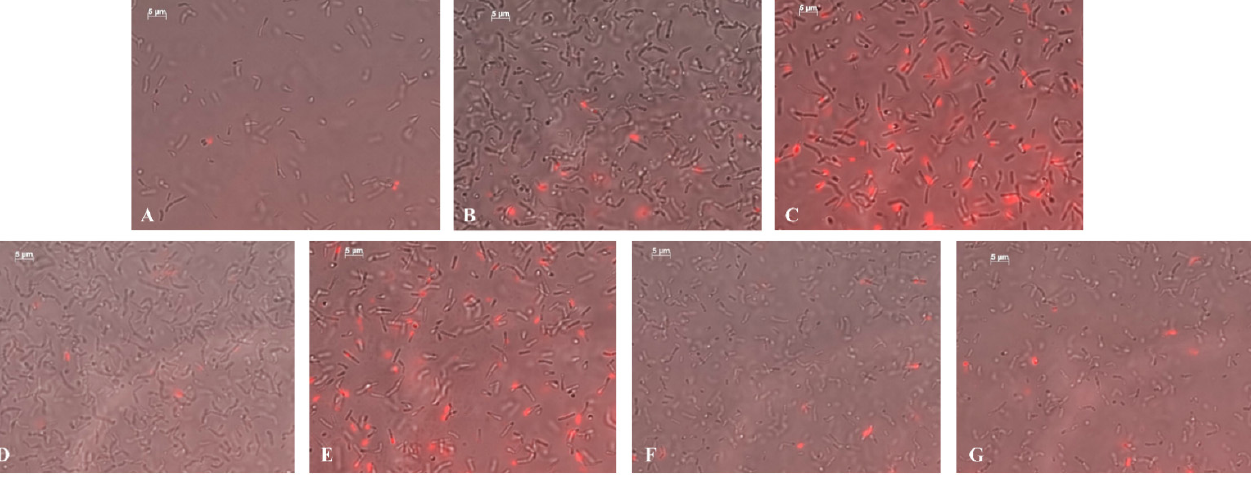
Figure 14. Micrographs of Cms biofilms in control ( A ) and in the presence of NCs (with concentrations of Mn 0.000625% and 0.00625% † in volume for AG-Mn ( B ), AG-Mn † ( C ), AGS-Mn ( D ), AGS-Mn † ( E ), κ -CG-Mn ( F ), κ -CG-Mn † ( G ). Table 3. Effect of NC treatments on morphological parameters of Cms bacterium (length, width, and dead cell count) with concentrations of Mn 0.000625% and 0.00625% † in volume.